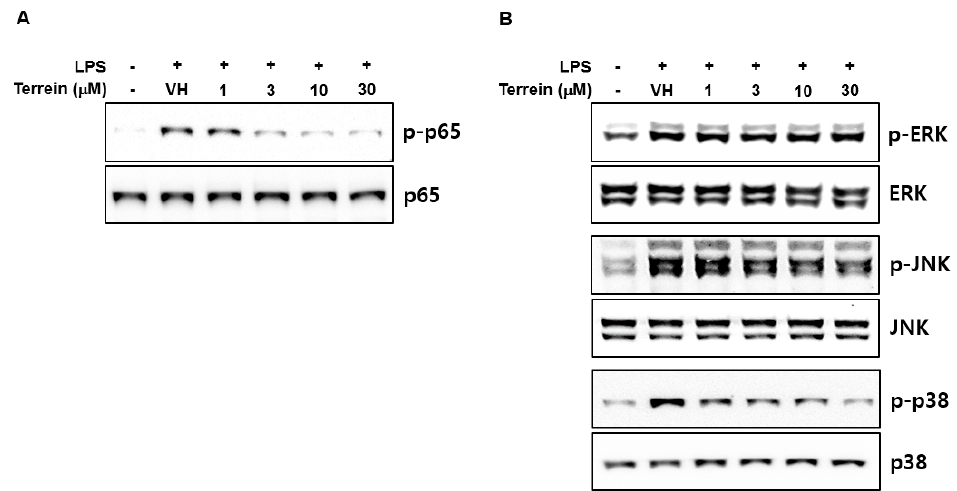
Figure 6. Effect of terrein on the activation of NF − κ B and MAPK signaling pathway. RAW 264.7 cells were pretreated with the indicated concentrations of terrein for 1 h before being incubated with LPS (200 ng/mL) for 1 h (for p65) or 10 min (for MAPKs). The phosphorylation of p65 ( A ) and MAPKs ( B ) was examined using Western immunoblot analysis.